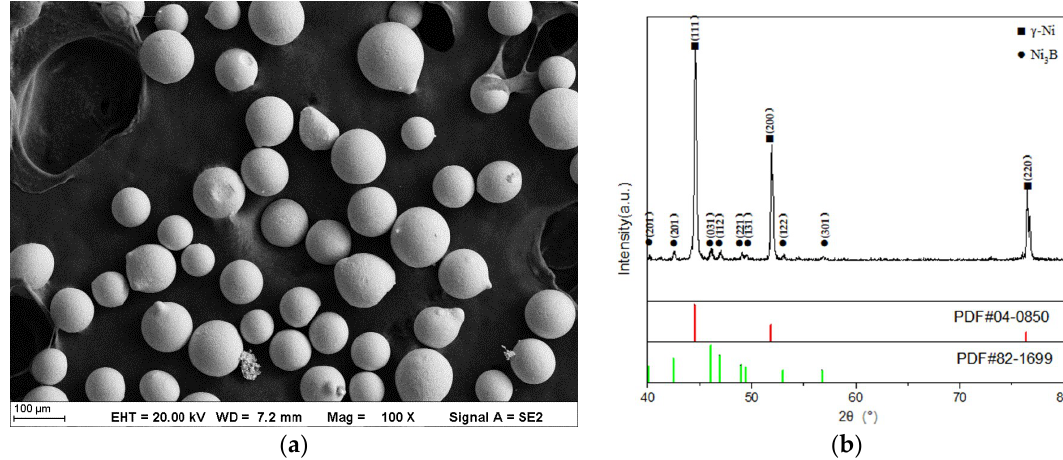
Figure 3. SEM image and XRD patterns of the powder: ( a ) SEM image of powder shape and size and ( b ) XRD pattern of the powder.